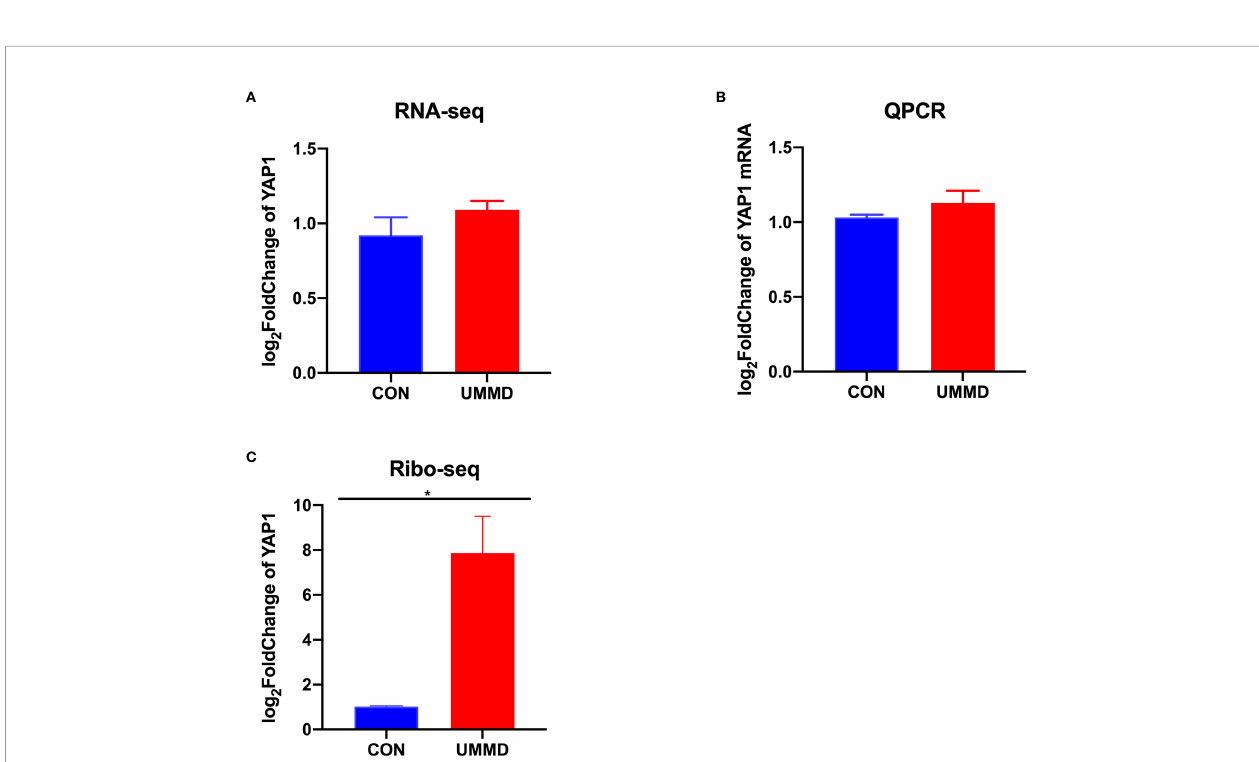
FIGURE 3 | UMMD treatment in vivo promotes YAP1 translation ef fi ciency. (A) RNA-seq detection of YAP1 expression in CMM mouse tumor tissues; (B) RT-qPCR detection of YAP1 mRNA expression in CMM mouse tumor tissues; (C) Ribo-seq detection of YAP1 expression in CMM mouse tumor tissues. * p <